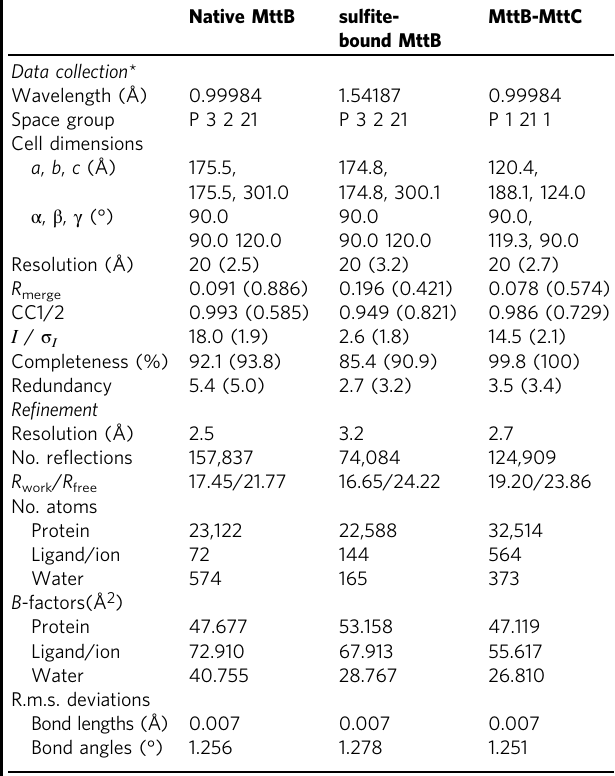
Table 1 Data collection and re fi nement